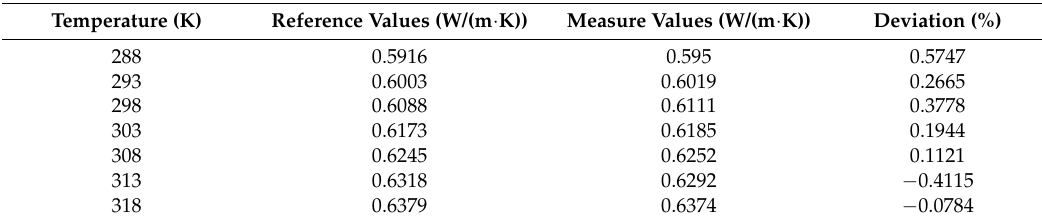
Table 1. Thermal conductivity measurement and analysis for